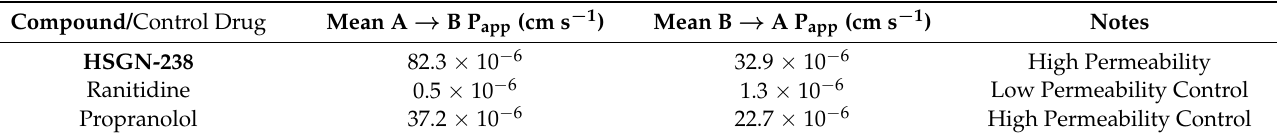
Table 4. Caco-2 permeability analysis for HSGN-238 and control